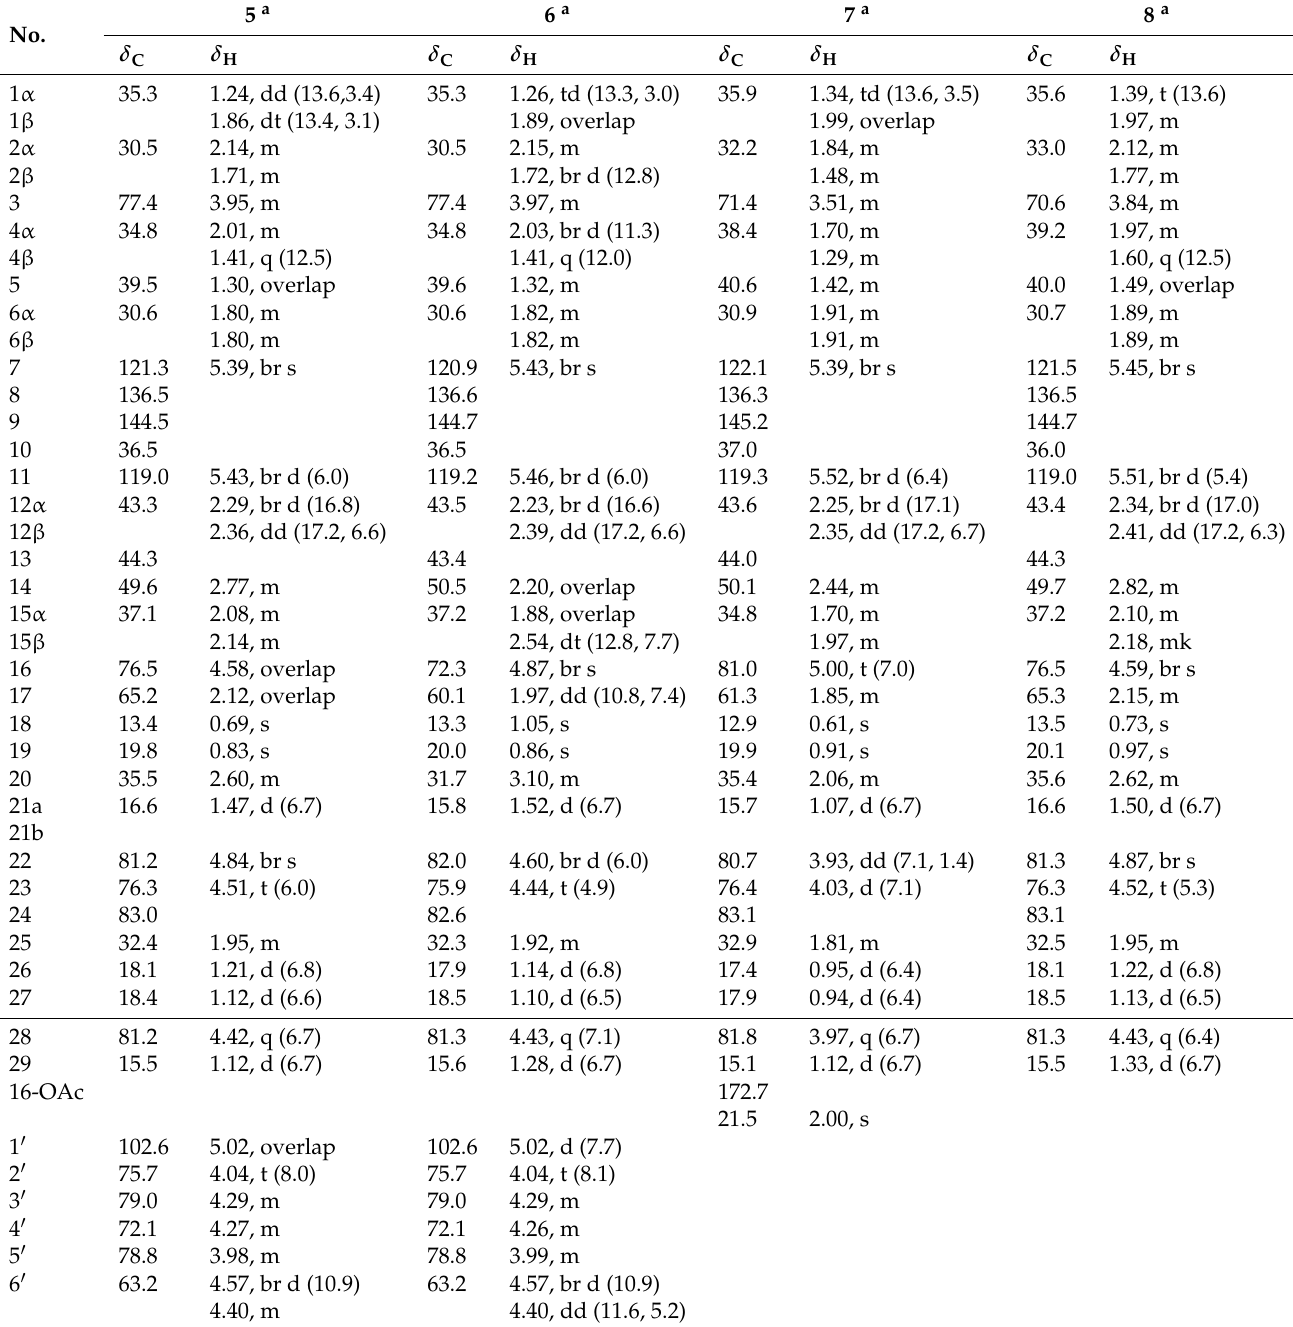
Table 2. 1 H (600 MHz) and 13 C NMR (150 MHz) data for compounds 5 – 8 ( δ in ppm, J in